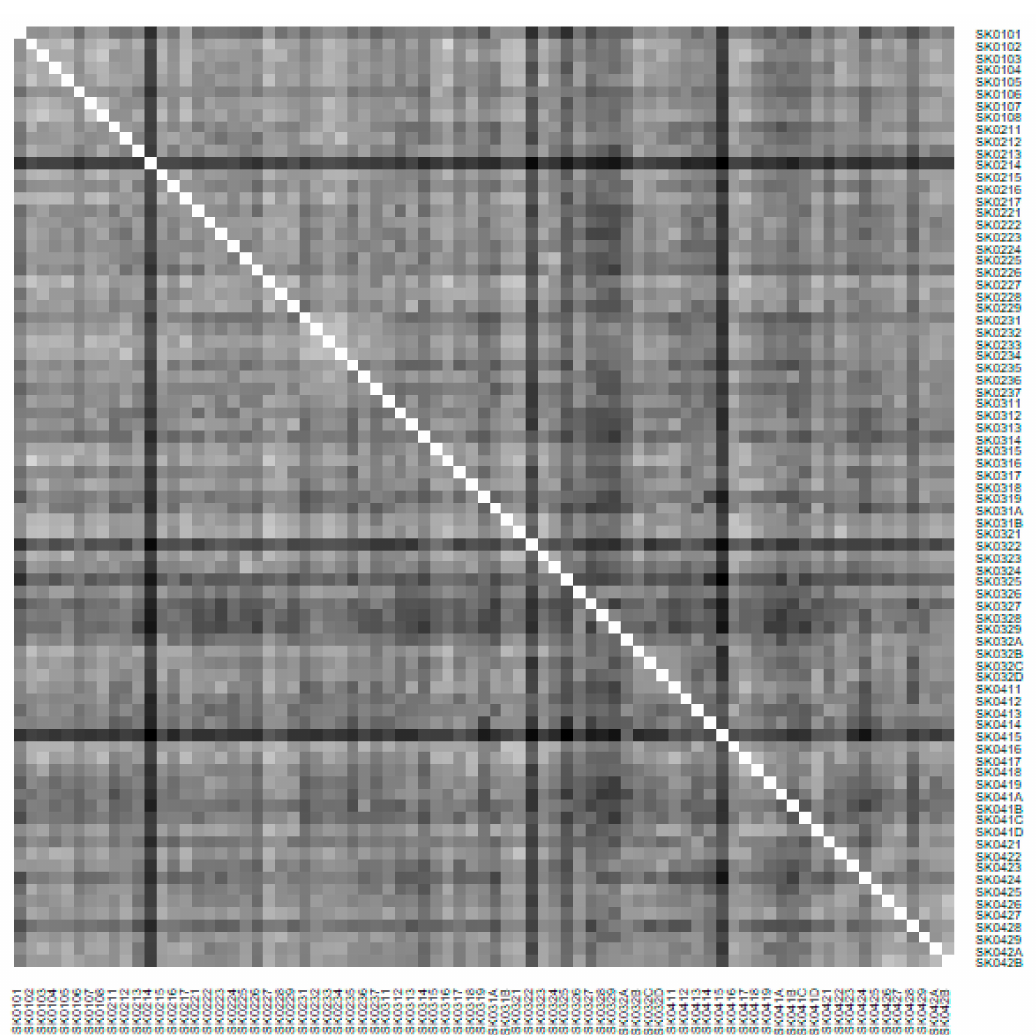
Figure 18. Preventable mortality heat map of the districts for the female sex in the whole explored period. Source: own elaboration by the